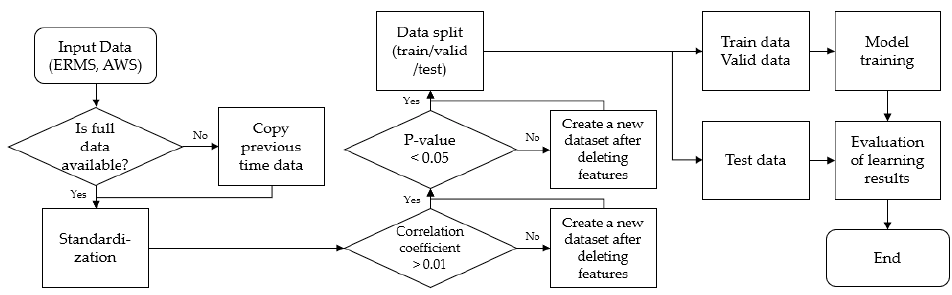
Figure 8. The flowchart of gamma exposure rate prediction.